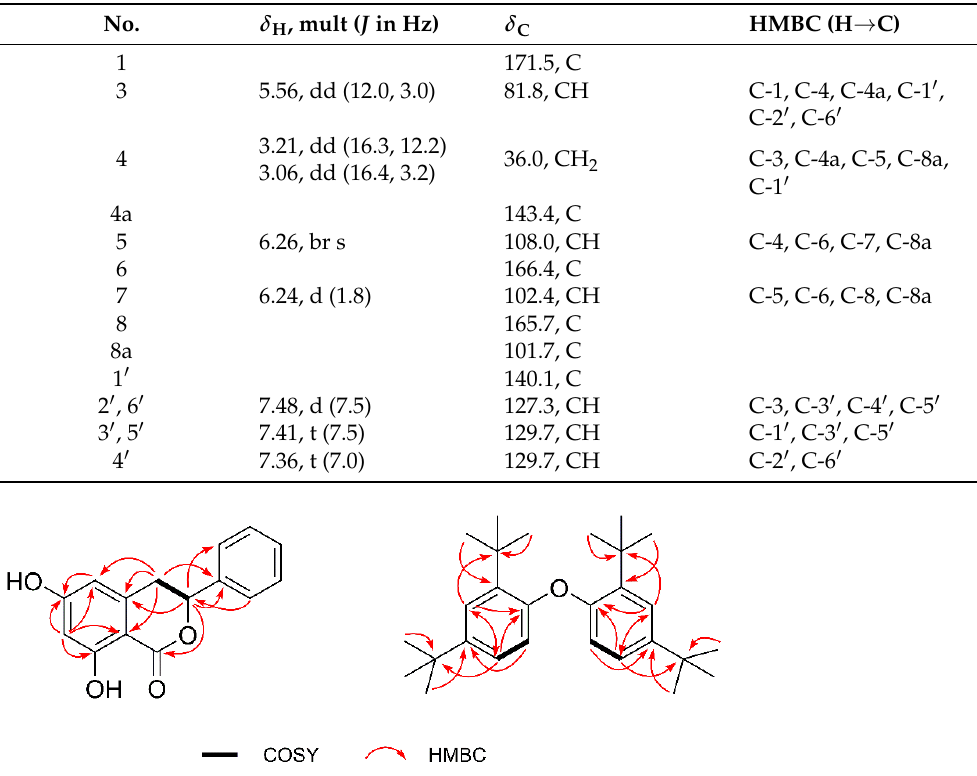
Figure 2. 1 H- 1 H COSY, key HMBC correlations of 1 – 2 . Table 1. 1 H-NMR (600 MHz), 13 C NMR (150 MHz) data, and HMBC correlations of compound 1 in